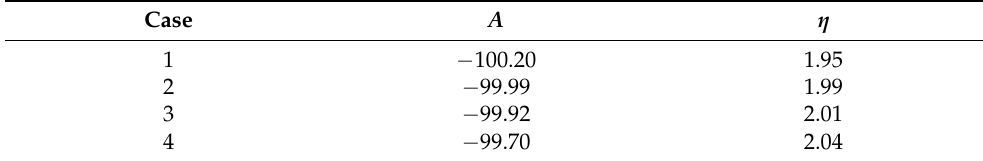
Figure 6. Comparison of the linearization curves for four cases. Table 2. Different parameter values for four cases.